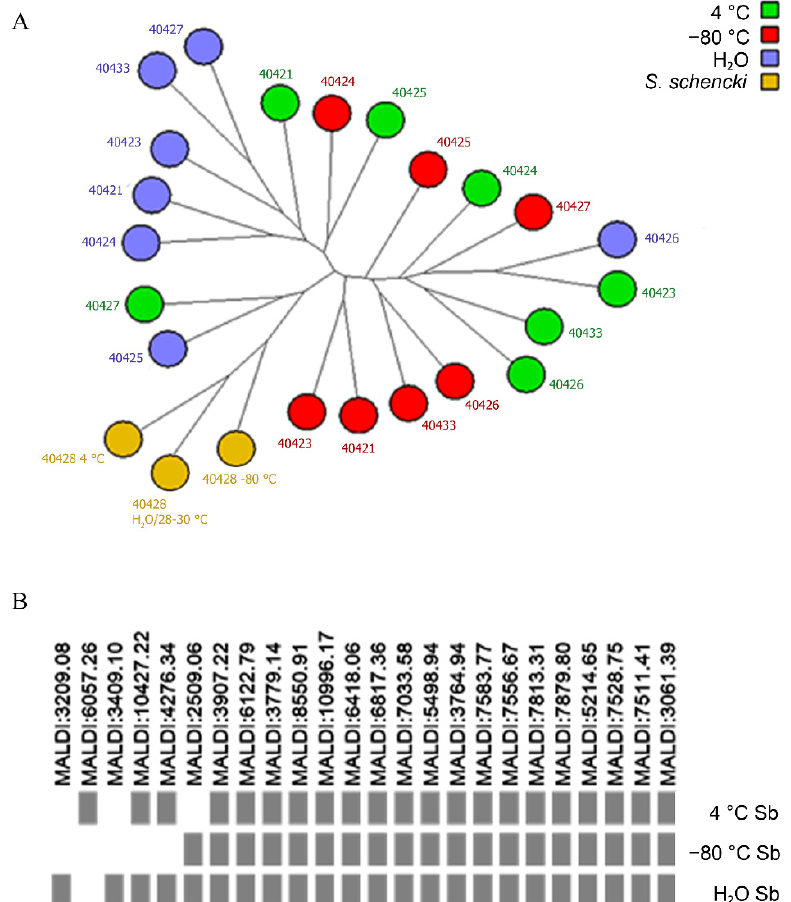
Figure 4. ( A ) Phylogenetic tree neighbor joining based on Pearson correlation constructed with spectra obtained by MALDI-TOF MS of 8 isolates distributed according to species and each of the three preservation methods; ( B ) proteomic profile of MALDI-TOF MS for an isolate of S. brasiliensis CMRVS 40424 (IPEC 47547) selected to exemplify the differences in the proteomic profile of the same isolate preserved by different methods. The rectangles in gray color indicate the presence of protein spectra, with molecular weight indicated on the